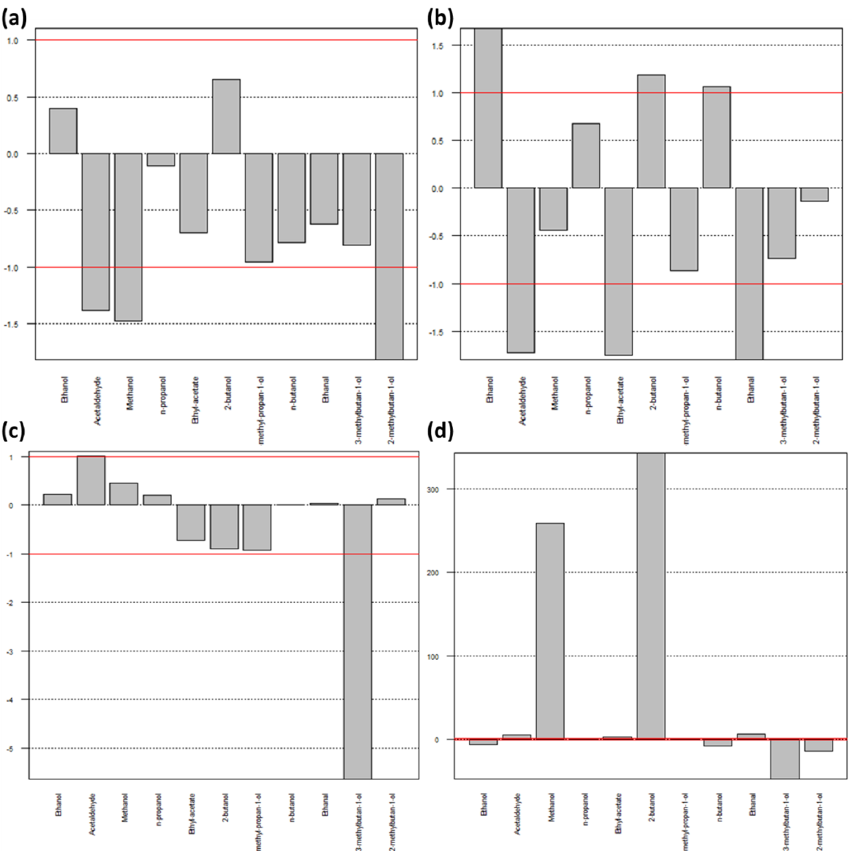
Figure 5. Upper part: T 2 -contribution plots of one of the suspicious samples projected onto ( a ) “grappa” and ( b ) “wine spirit” models. Lower part: Q-contribution plots of one of the suspicious samples projected onto ( c ) “grappa” and ( d ) “wine spirit” models. Red lines indicate the normalized acceptability limits at a significance limit of 0.05. Contribution plots of the second suspicious sample are almost identical to the showed ones.